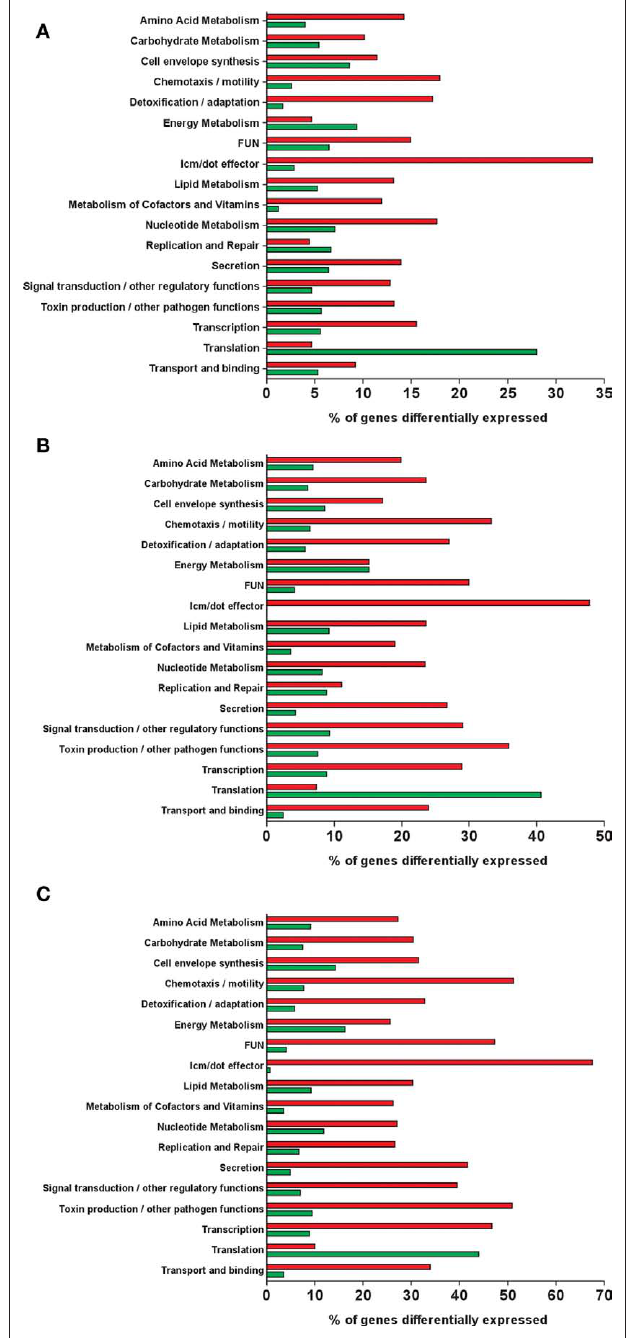
FIgURe 5 | Fraction of genes in orthologous groups deferentially expressed during infection. Number of genes significantly induced (red bar) or repressed (green bar) intracellularly at T0 (a) , T6 (B) , and T18 (C) compared to the E phase control.